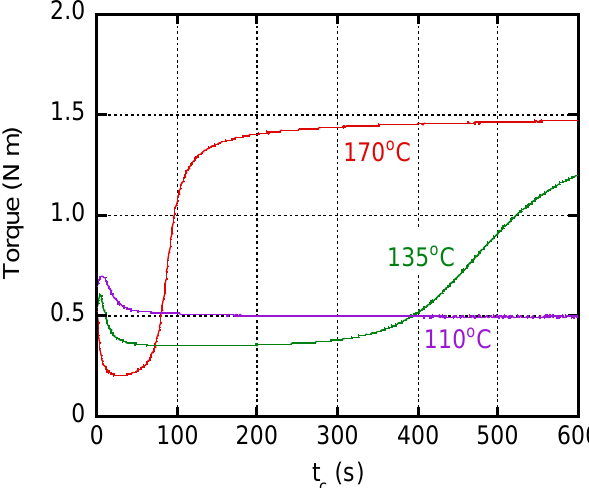
Figure 1. Torque curves plotted against curing time t c at various temperatures. The temperature dependence of tensile storage modulus E’ and loss tangent tan δ at 10 Hz is shown in Figure 2. The glassy, transition, and rubbery regions were clearly de- tected for all samples.